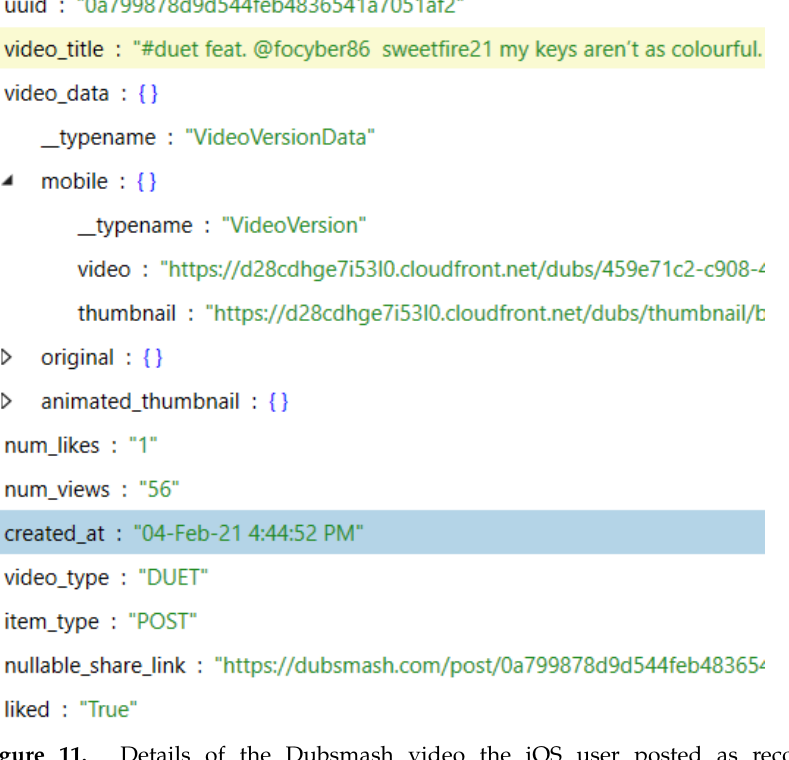
Figure 11. Details of the Dubsmash video the iOS user posted as recovered from the 7472eeb55afa96525691d944b77f32fd.1 file on